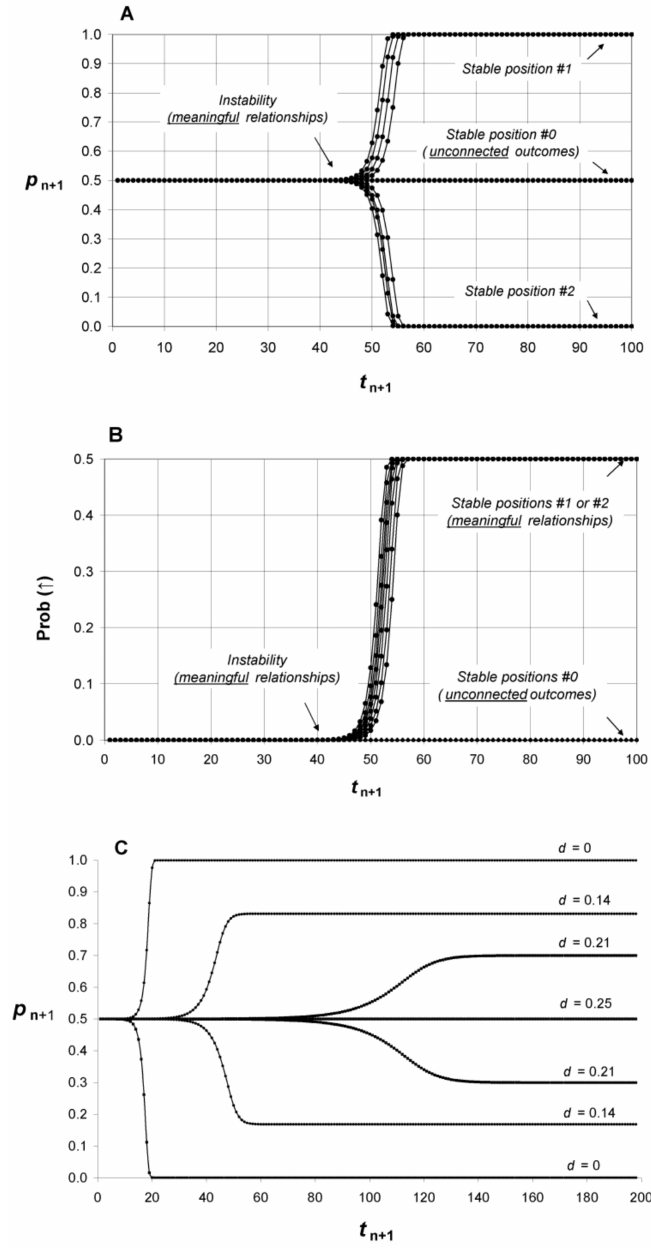
Figure 4. Emergence of relationships between “labels” and states of a deformable system (e.g., a biological system). Panel ( A ) describes the probability to observe a meaningful relationship after O-S and O ’- S interact if the fluctuations of the system are taken into consideration (Equation (7)). There is a dramatic transition of the probability from 1/2 toward 1 or 0. If the results expected by the experimenters are the simple sum of unconnected variables then no relationship emerges and Prob ( direct ) remains equal to 1/2. Panel ( B ) corresponds to the emergence of an “activated” state for meaningful relationships. Panel C is obtained by varying the independence of the events expected by O and O ’ (from d = 0.25 to d = 0) using Equation (15) (see text). The mathematical sequences presented in panels A and B have been obtained after eight computer calculations. Each probability p n+1 of the sequence is calculated by using p n and a probability fluctuations ε n+1 which is randomly obtained between –0.5 and +0.5 × 10 –15 . For panel ( C ), the range of probability fluctuation was from –0.5 to +0.5 × 10 –5 for a better display. Note that these figures are obtained before considering that only one of the two stable positions—namely stable position #1—is allowed (see